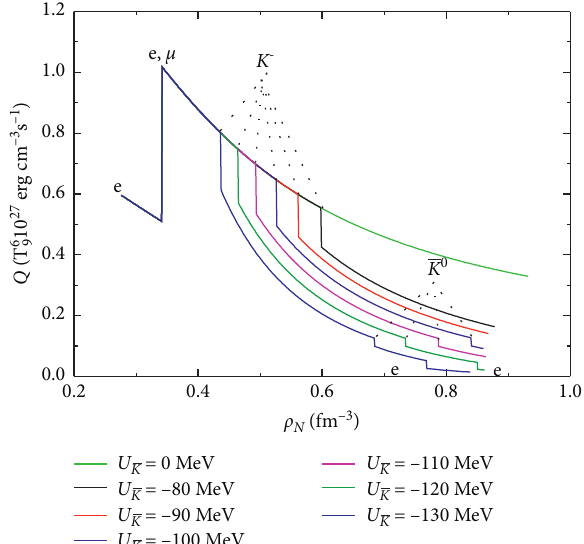
Figure 2: Neutrino emissivities of the nucleonic direct Urca processes as a function of the nucleonic density ρ N for the cases of including and not including K − and K 0 condensed phases. For comparison, the thick line represents the corresponding values in npe μ matter.